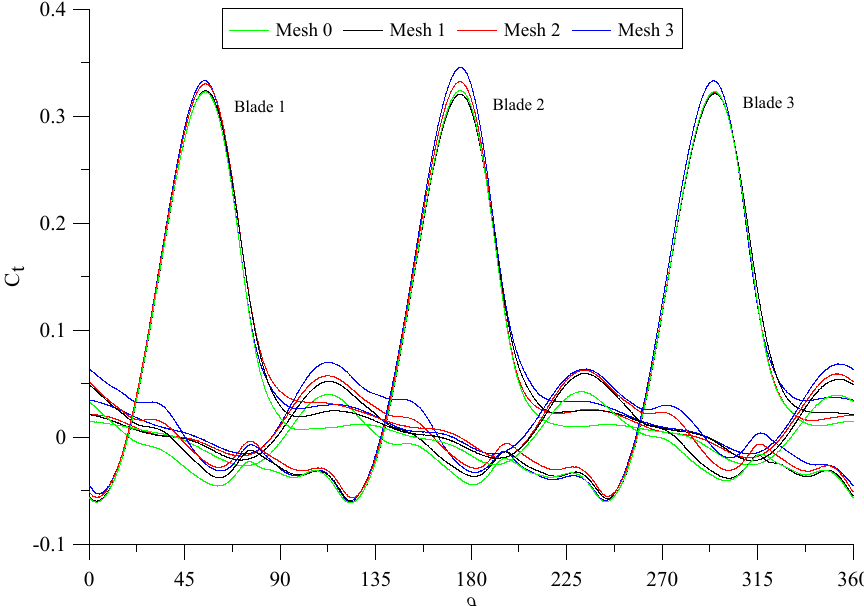
Figure 3. Influence of mesh discretization on blade torque